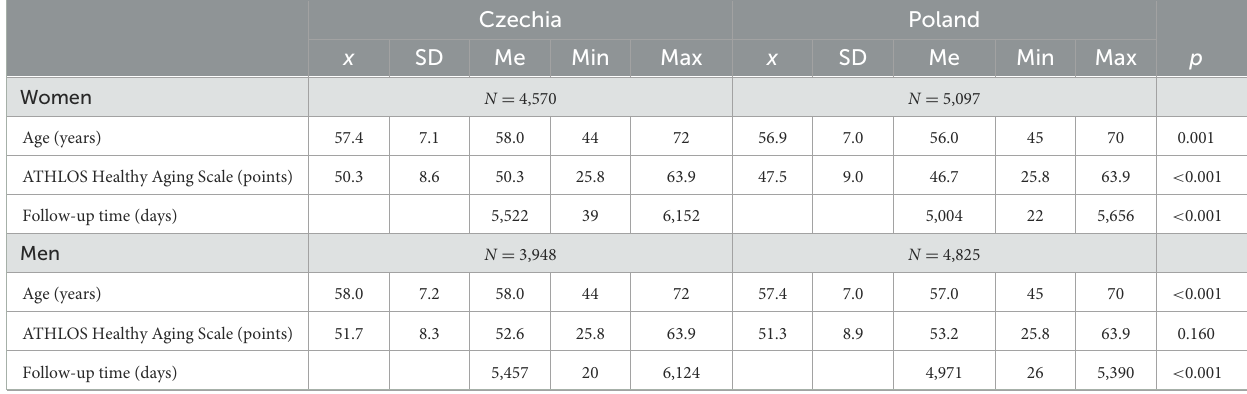
TABLE 1 Distribution of age, ATHLOS Healthy Aging Scale score, and follow-up time by country and gender. Czechia Poland